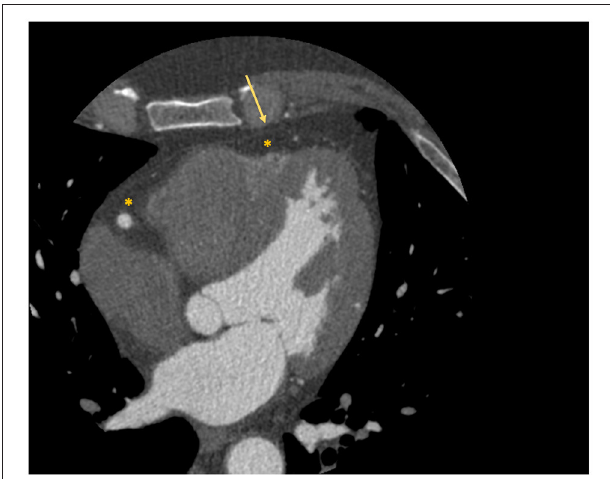
FIGURE 2 | Localization of epicardial adipose tissue at cardiac CT scan. The figure depicts an example of visualization of the epicardial adipose tissue with a cardiac CT scan. The asterisk identifies the hypodense area of adipose tissue; while the arrow identifies the visceral